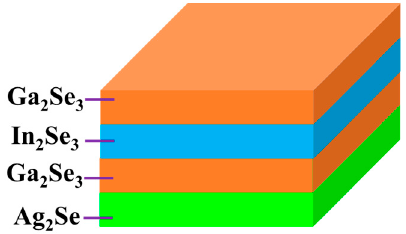
Figure 1. Structure of the AgInGaSe 2 (AIGS) precursor.